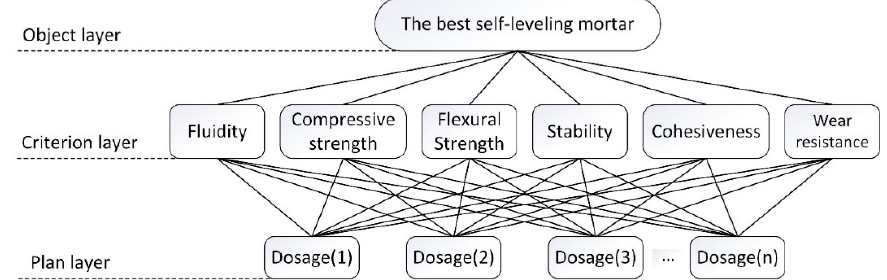
Figure 7. Hierarchy structure model for performance evaluation of SLM based on experimental tests.